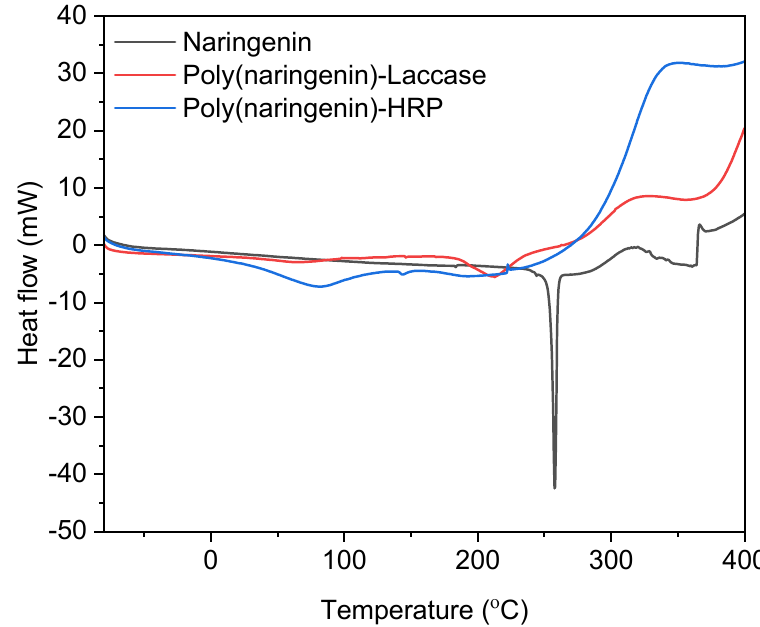
Figure 7. DSC analysis of reference naringenin and its polymeric forms. Table 4. DSC analysis of naringenin poly(naringenin)-laccase and poly(naringenin)-HRP.